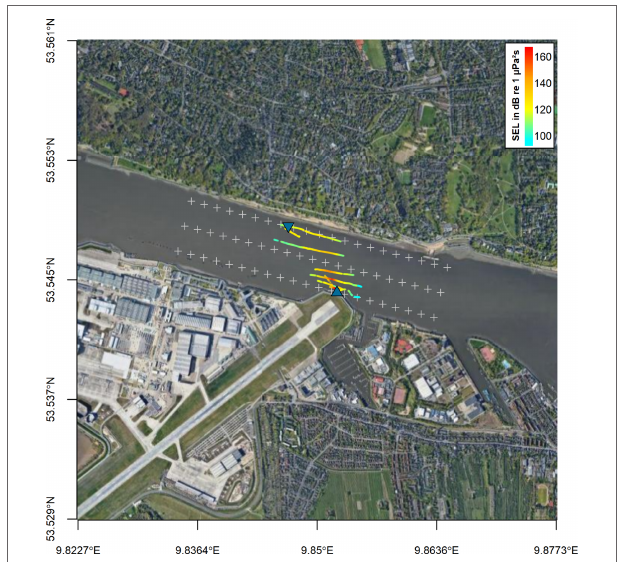
FIGURE 3 | Study area in the Elbe River on the West side of Hamburg. The positions of the underwater flowmeters are shown by blue triangles. The positions of recorded signals from the flowmeter in the South are marked by points, color coded for the received SEL (RMS in dB re 1 µPa²s). Signals from the flowmeter in the North are not shown. Grey crosses mark the extent of the modelled sound field with a width of 391 m and a length of 2001 m. The distance between two crosses on a line is 100 m. The map was generated using the R-package “ RgoogleMaps ” (Loecher and Ropkins,